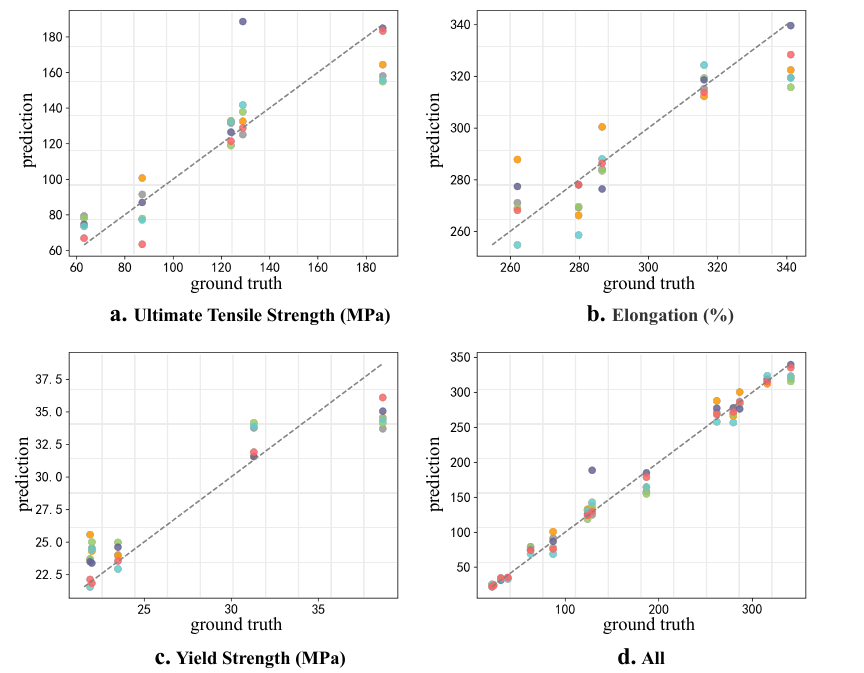
Figure 10. Fitting result. “ Ultimate Tensile Strength” means that UTS is used as the label during training and testing; “Elongation” means that EL is used as the label during training and testing; “Yield Strength” means that YS is used as the label during training and testing; “All” means that UTS, EL, and YS are used together as the label of the data in the experiment, i.e., multi-label learning and prediction